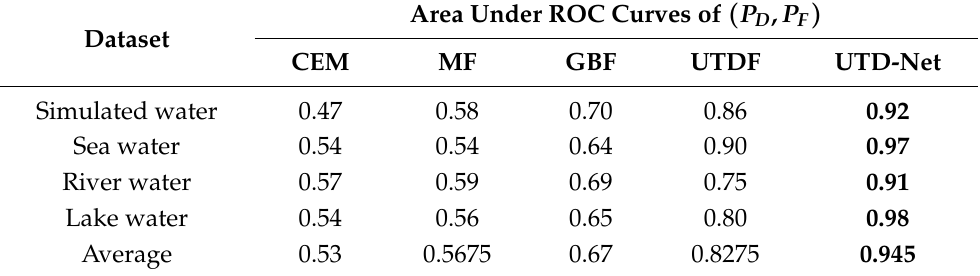
Table 5. The AUC values of ( P D , P F ) of underwater target detection results for compared methods on all datasets.